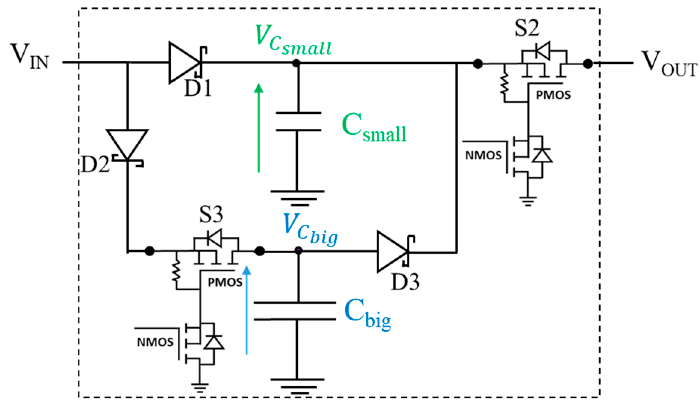
Figure 11. New version of the variable storage architecture using discrete MOS switches.